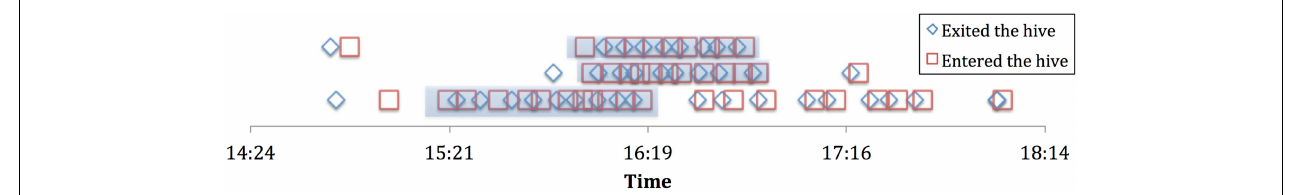
FIGURE 1 | Sample employment histories for 3 employed foragers from experiment 2a. Highlighted portion is the “employment” phase.